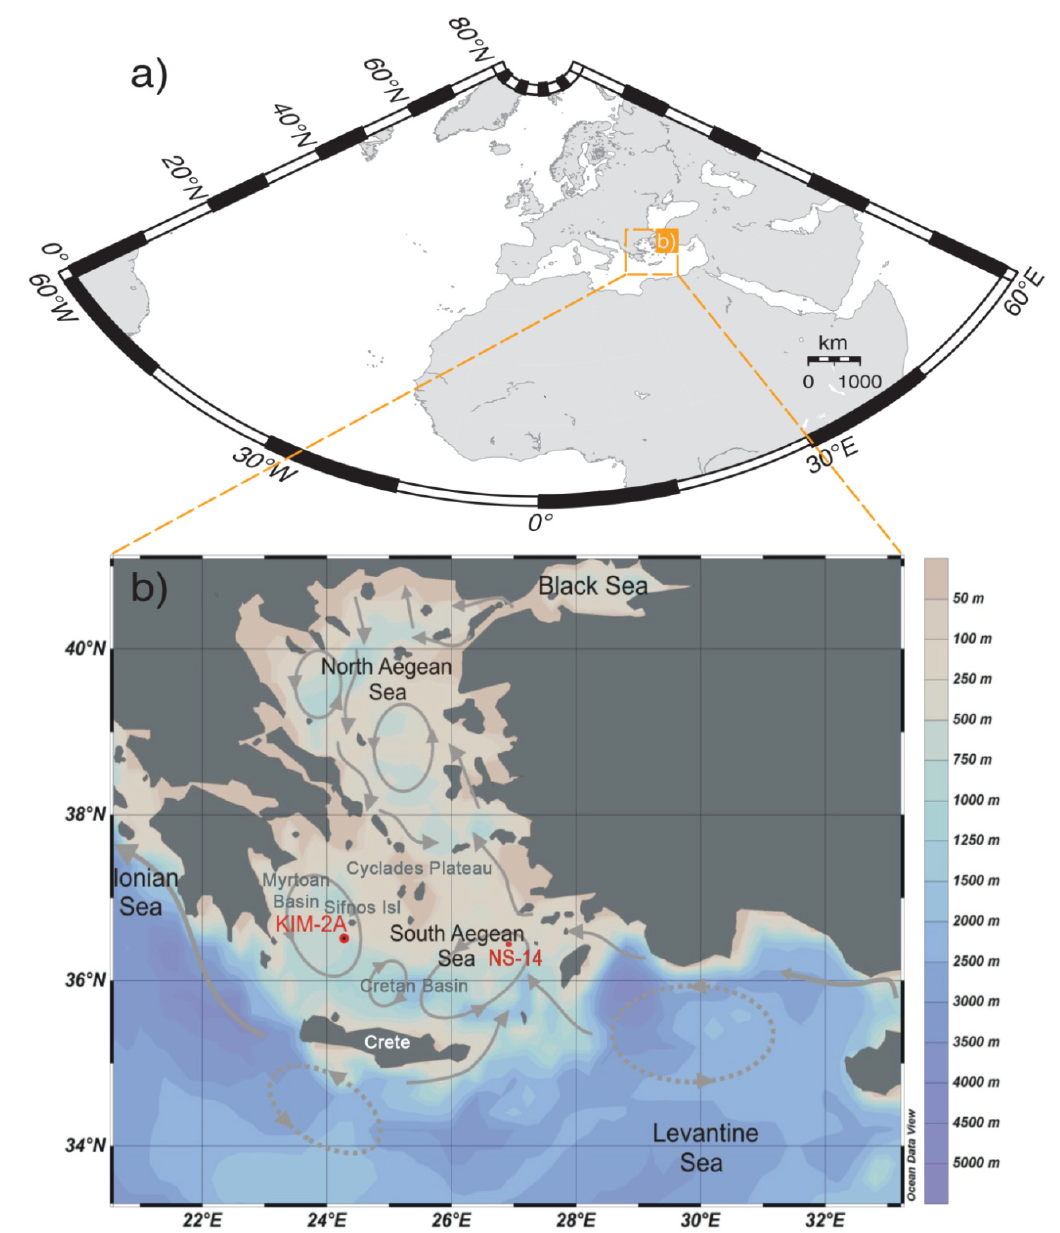
Figure 1. ( a ) Map of the Mediterranean Sea (including the Aegean Sea); ( b ) inset shows location of the south Aegean sediment core KIM-2A (36°95.464 ′ N, 24°06.354 ′ E, 640 m depth; in red), and the main patterns of sea surface-water circulation (grey arrows), cyclonic (solid grey circles) and anticyclonic gyres (dashed grey circles) in the Levantine and Aegean Seas. Location of the core NS-14 [7,16], that was used for the age model construction. Map contours show paleobathymetry (water depth in meters) of the study